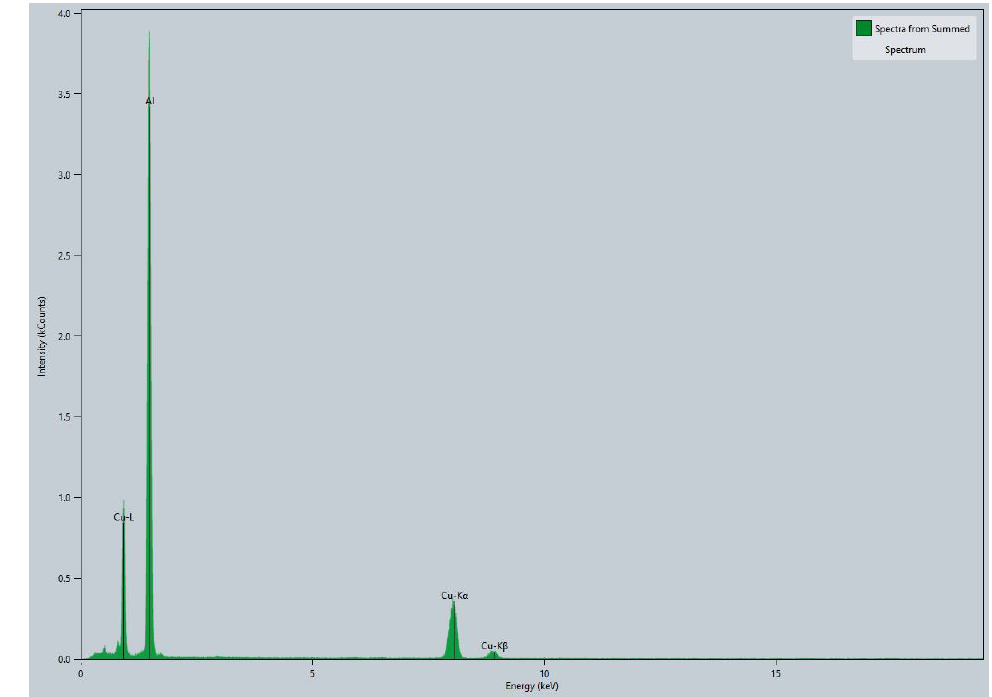
Figure 9. EDS energy spectrum analysis.